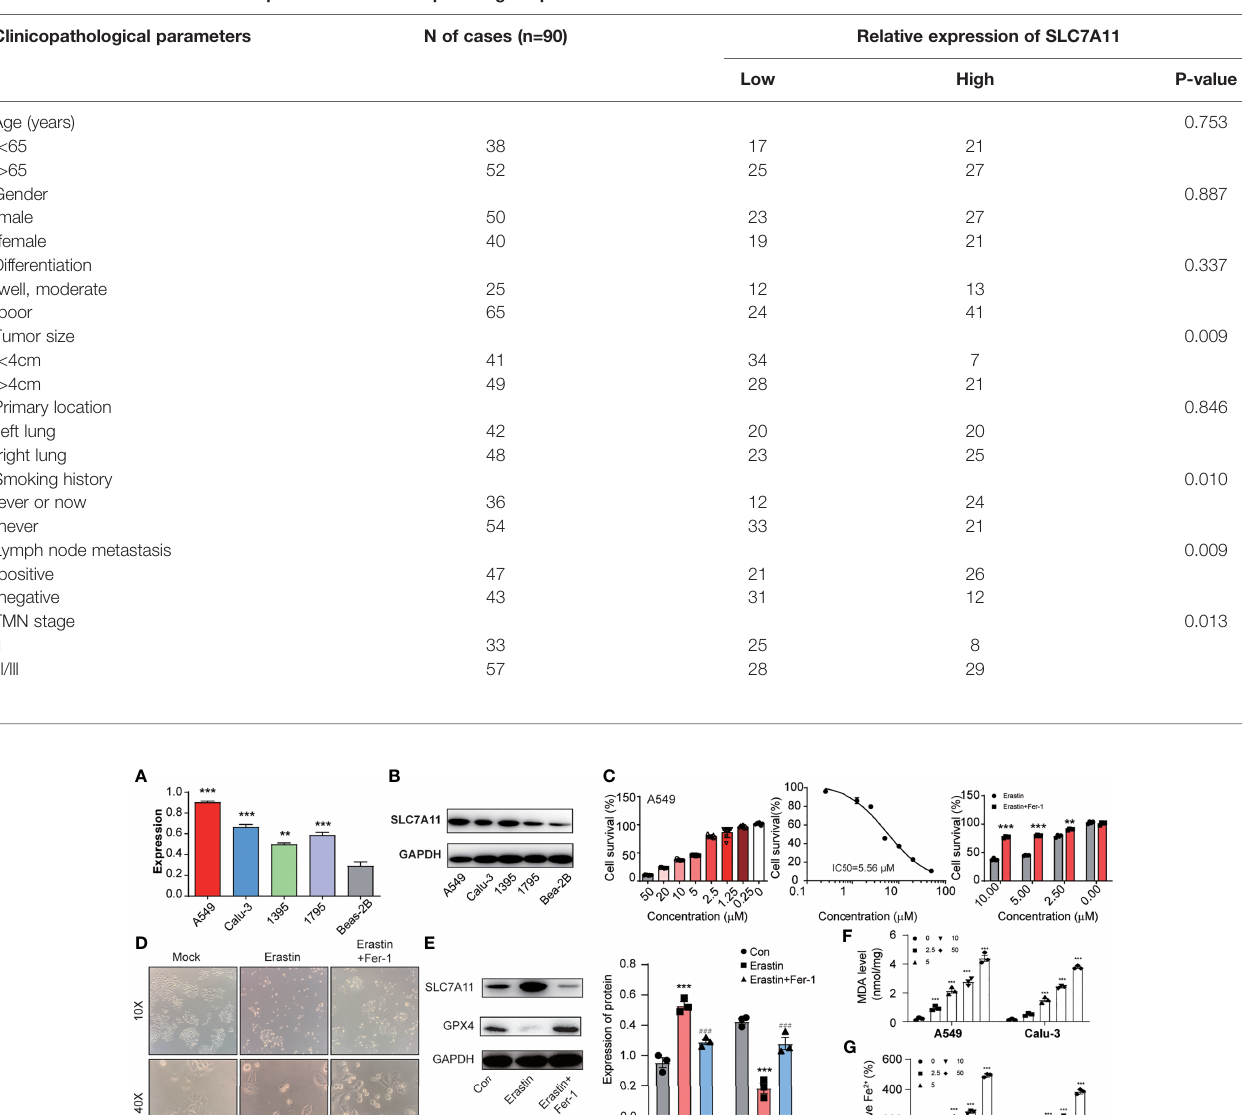
TABLE 1 | Multiple variables cox proportional hazards analysis in 90 NSCLC patients. Correlation between SLC7A11 expression and clinicopathological parameters of NSCLC Clinicopathological parameters N of cases (n=90) Relative expression of SLC7A11